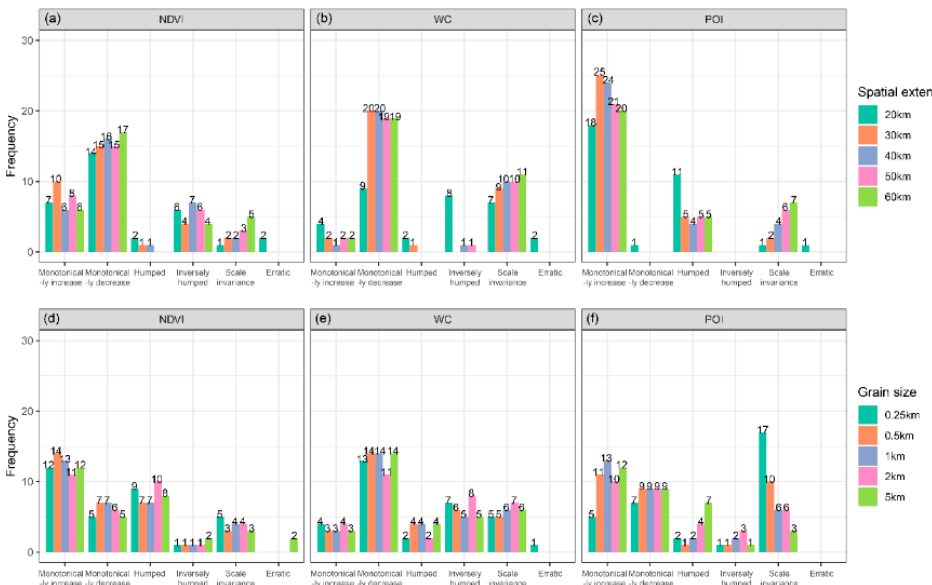
Figure 6. The frequency (number of cities) distributions of six types of scaling relations with respect to grain size (at each fixed spatial extent, a – c ) and spatial extent (at each fixed grain size, d – f ) for the relative importance of NDVI, water cover (WC), and POI density. The number of cities (the frequency) that had a specific scaling relation type is annotated above the corresponding bar.